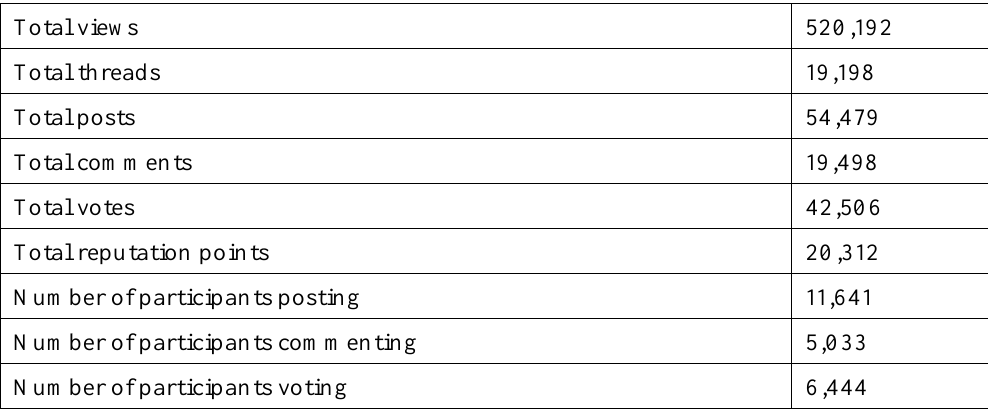
Discussion Forum Data, English Composition I: Achieving Expertise,